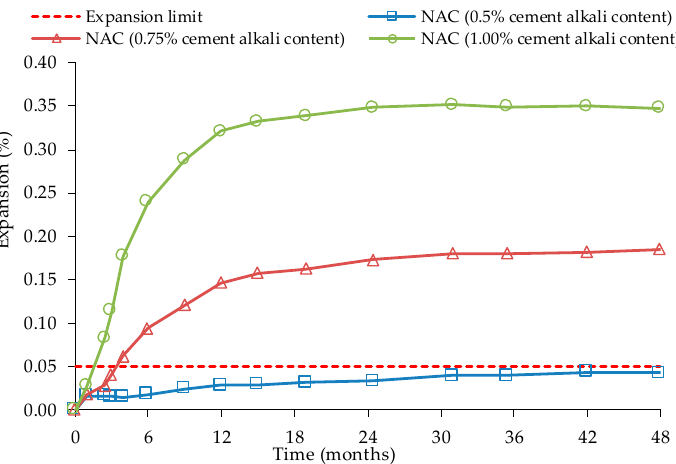
Figure 3. Expansion of NA with cements of different alkalis content in ASTM C227, adapted from [74].